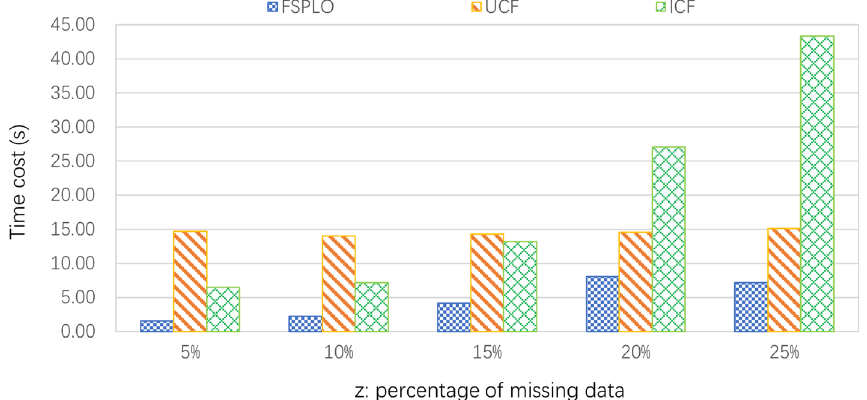
Fig. 4 Time cost comparison of FSPLO, UCF and